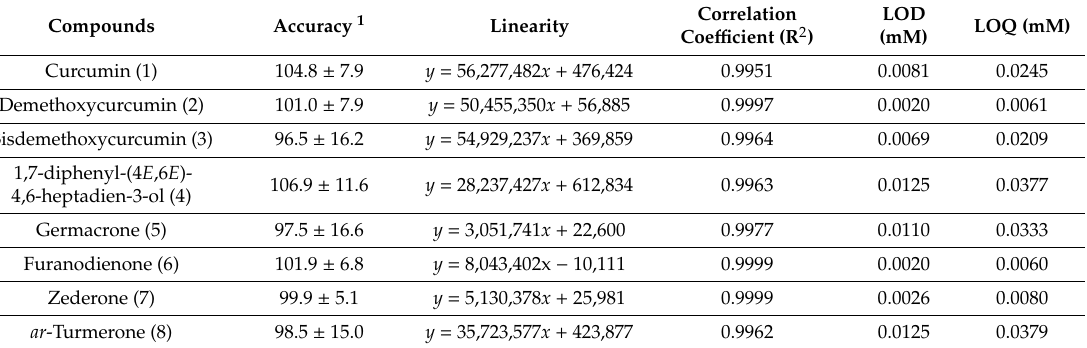
Table 1. Validation of HPLC assay of curcuminoids and sesquiterpenoids.